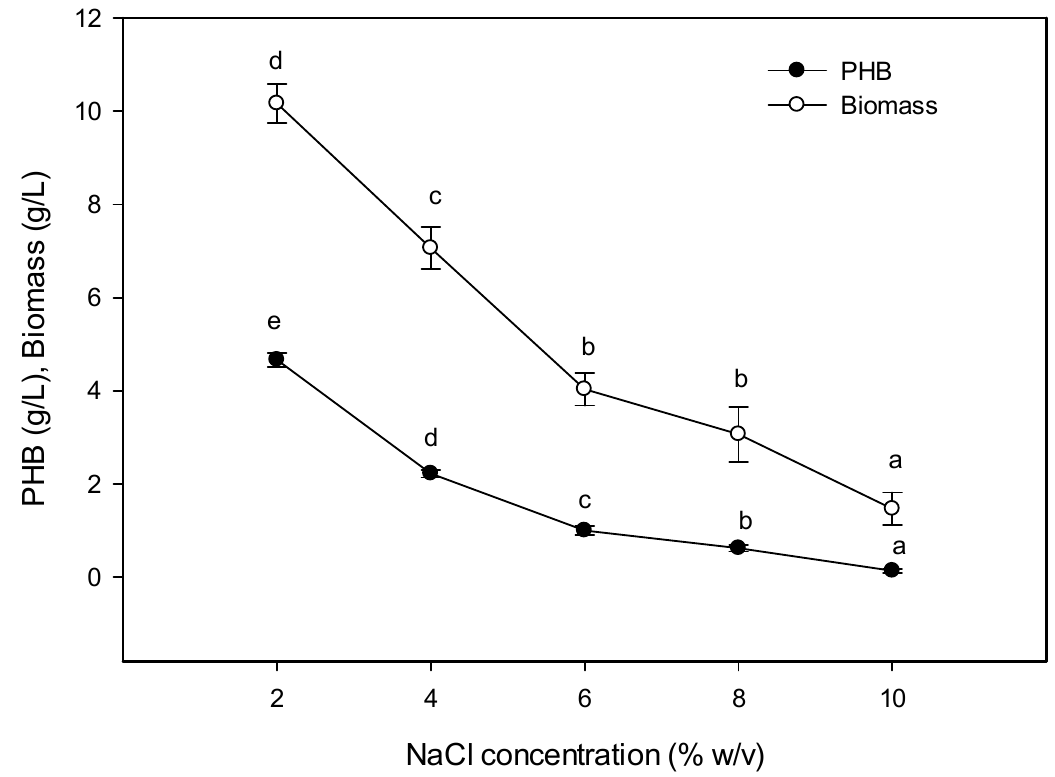
Figure 7. Effect of NaCl on the PHB production by E. aquimaris . The values set by oneself letter(s) on the same line were not significantly